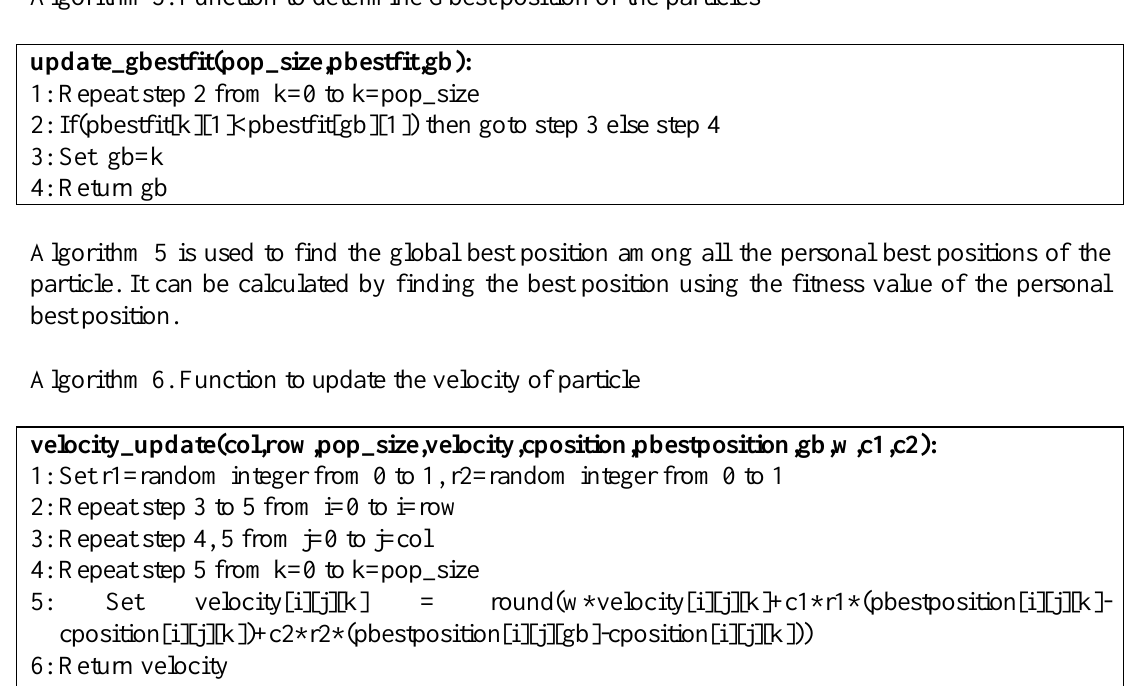
Algorithm 5. Function to determine Gbest position of the particles